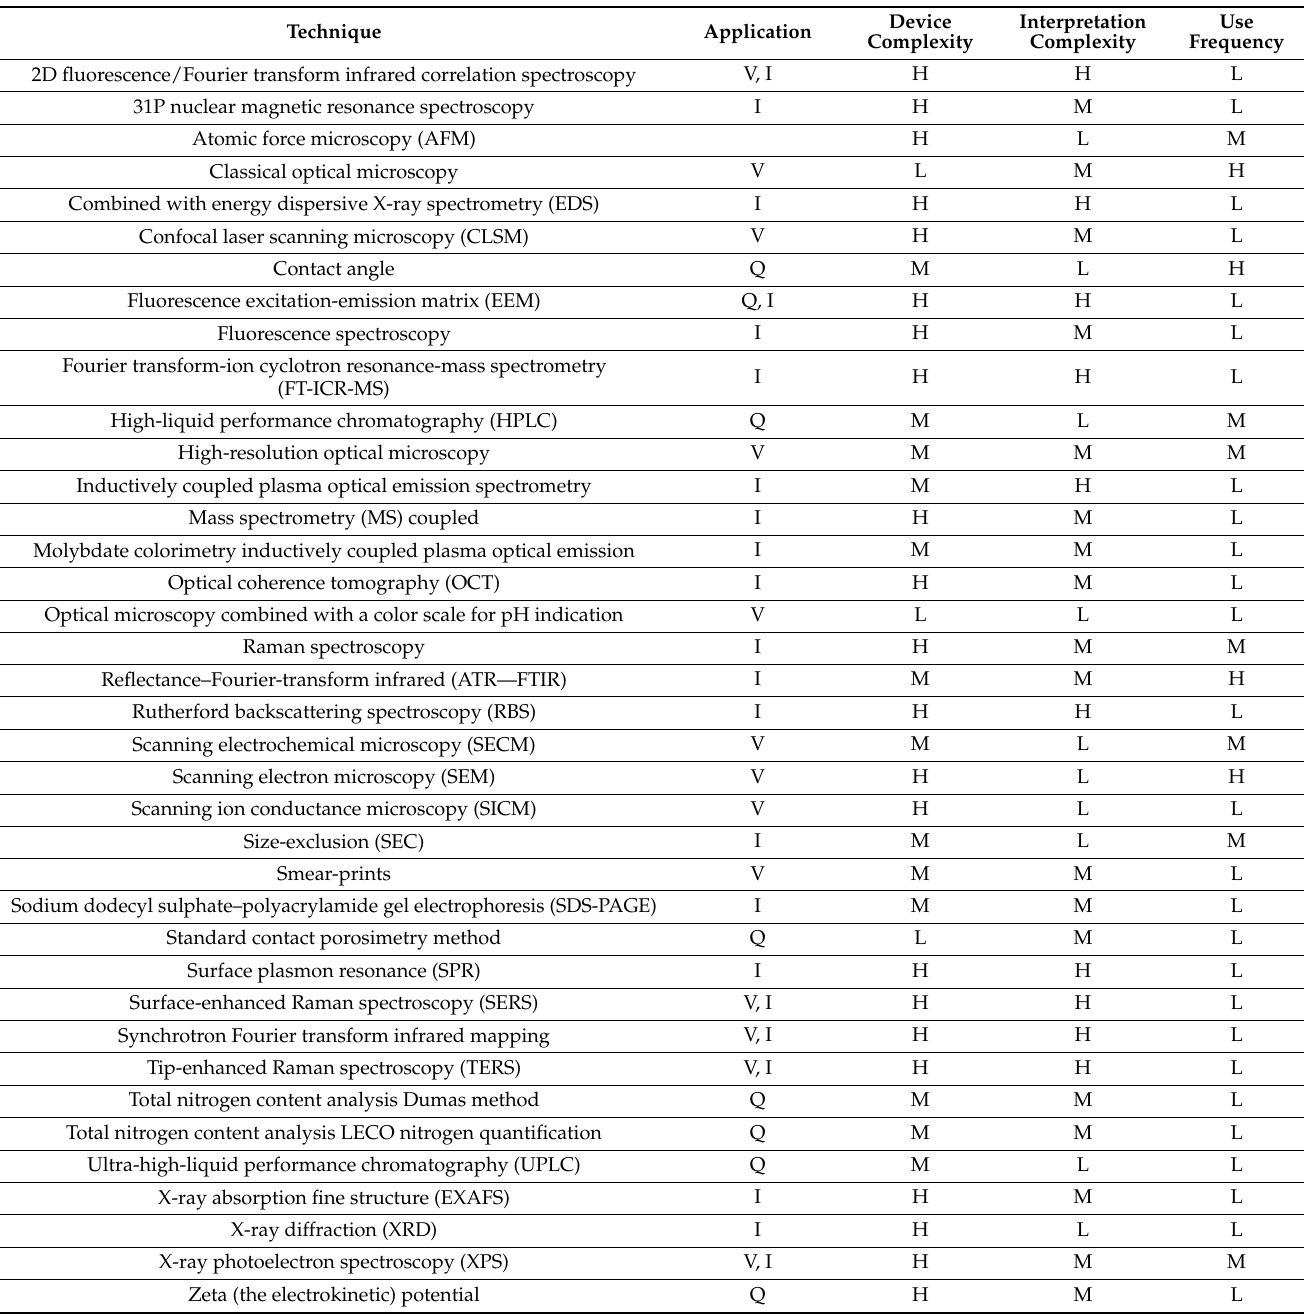
Table 5. Summary table of the different techniques used to study the various aspects related to the fouling of ion-exchange membranes. Here we use the following notation. Adapted from [33]. Device Technique Application